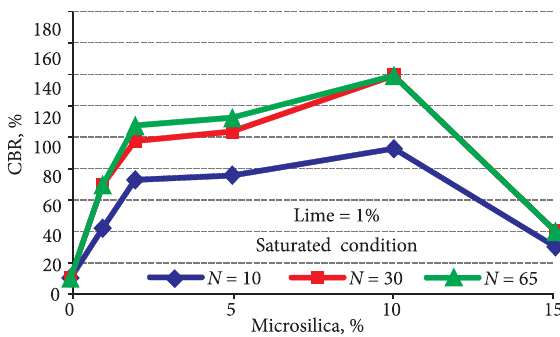
Fig. 9. CBR number of samples stabilized with 1% Lime and different values of Microsilica in saturated condition (10, 30 and 65 blows)